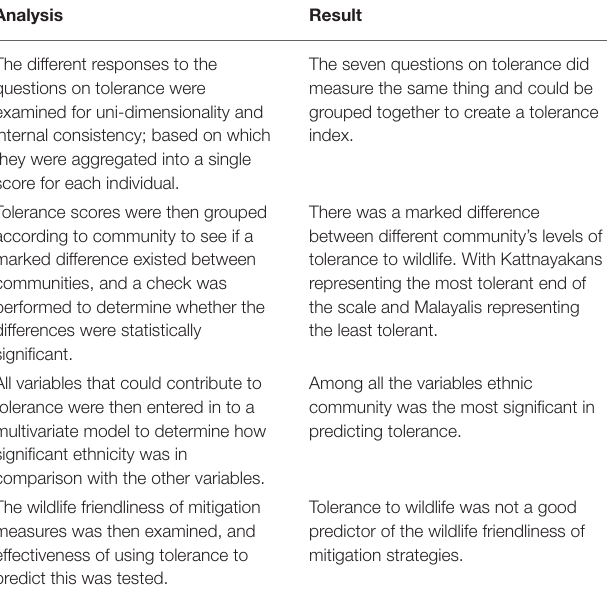
TABLE 3 | Summary of quantitative